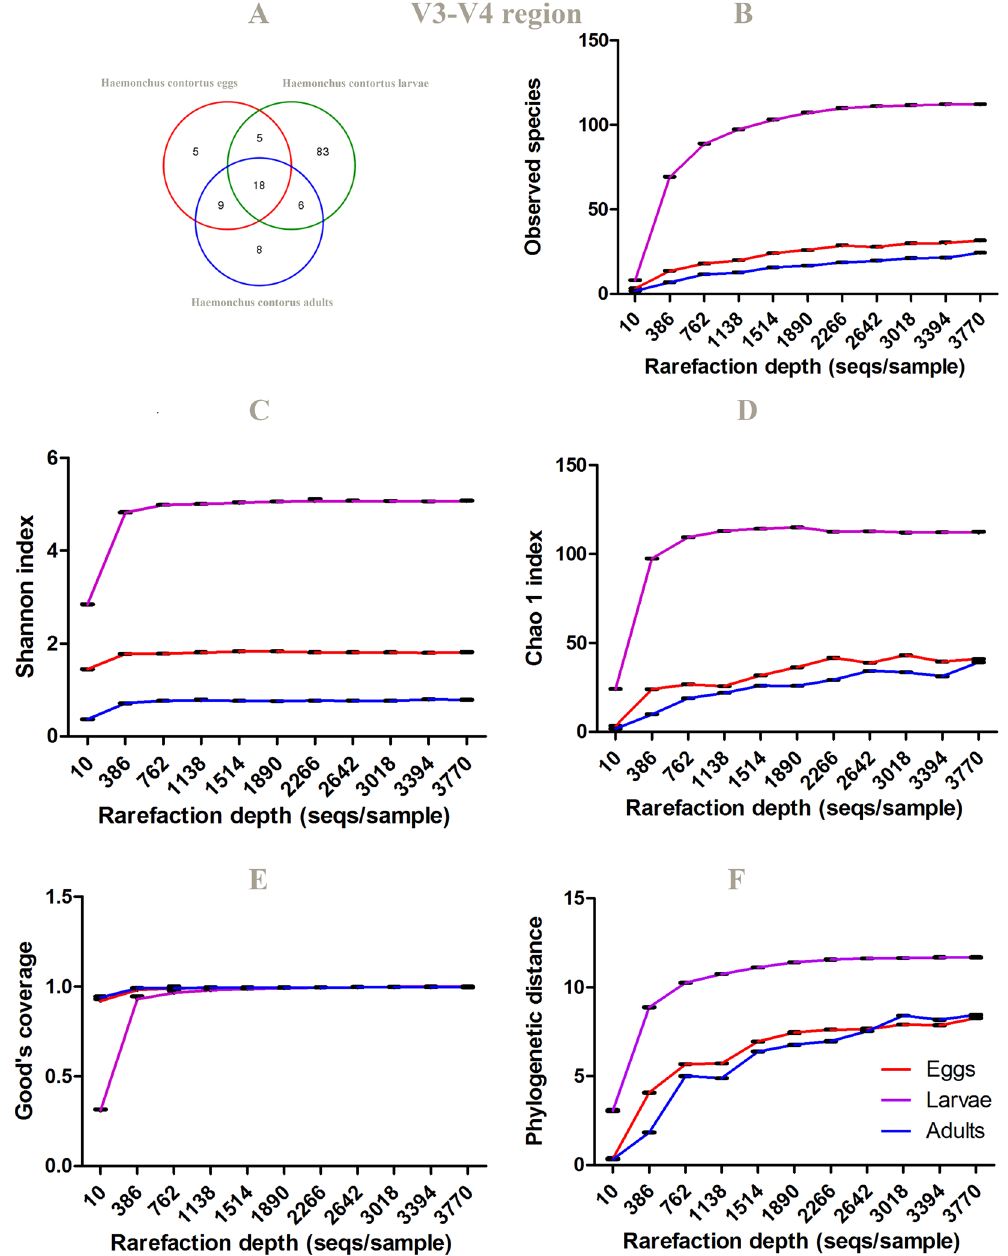
Figure 7. Venn graph (A ) and alpha diversity analysis ( B–F ) of H. contortus eggs, larvae and adults based on 16S rRNA gene sequence (V3-V4 region) of parasite microbiome and 97% identity. Rarefraction curve for ( B ). Observed species ( C ). Shannon, ( D ). Chao1, ( E ). good’s coverage and ( F ). PD whole tree. Data represent average values from pooled populations of eggs/larvae/adults (male and female) come from three different